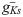
Slow potassium current regulates synchrony through PRC modulation.(A.) An increase in spike synchrony within upstates corresponds to the shift from a type 1 to type 2 PRC which occurs at high levels of gKs¯ as indicated by the distribution of inter-spike intervals. Time is shown as normalized phase based on the average period of firing during an upstate and the colors of the bar graphs corresponds to the PRCs shown in Fig 1. (B.) Characteristic voltage traces for 10 neighboring cells during an upstate for gKs‾=0.1 mS/cm2
top and gKs‾=1.5 mS/cm2
bottom. Each cell is represented by a different color. For both conditions are shown on a 40 ms time scale and the inset shows the entire upstate for the gKs‾=0.1 mS/cm2. Data shown here is for w
i → e = 24 μS/cm2.